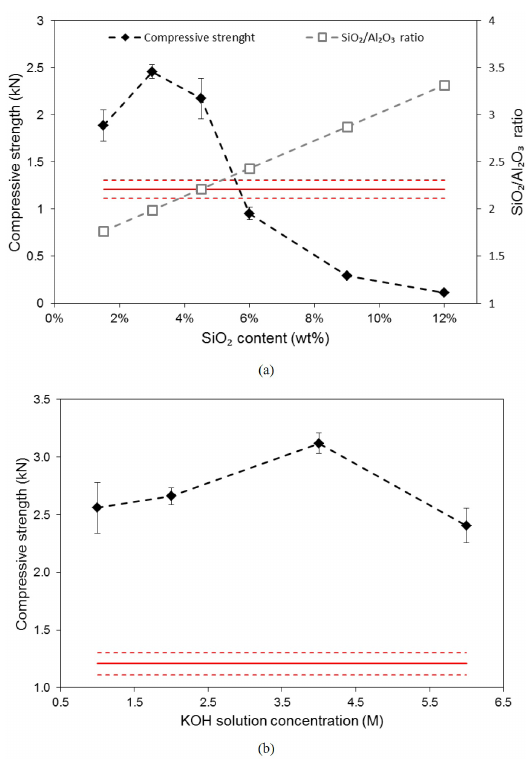
/Al O ratios 2 2 3 -2 M KOH pellets cured 2